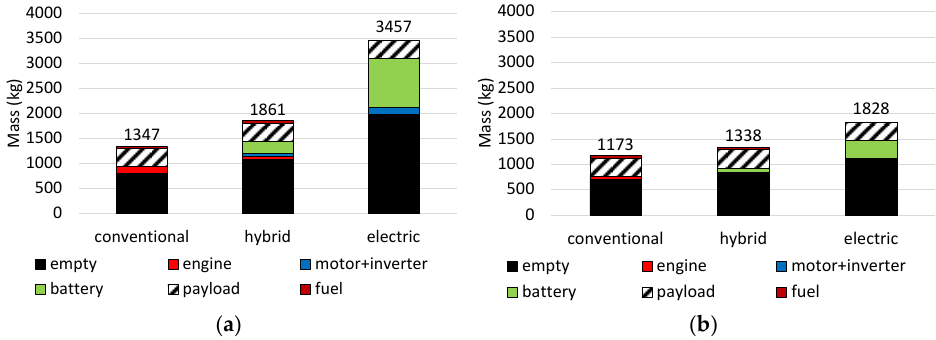
Figure 1. Estimated take-off mass (in kg) of the proposed powertrain for the aerial taxi. ( a ) Today’s technology; ( b ) 2035 technology.